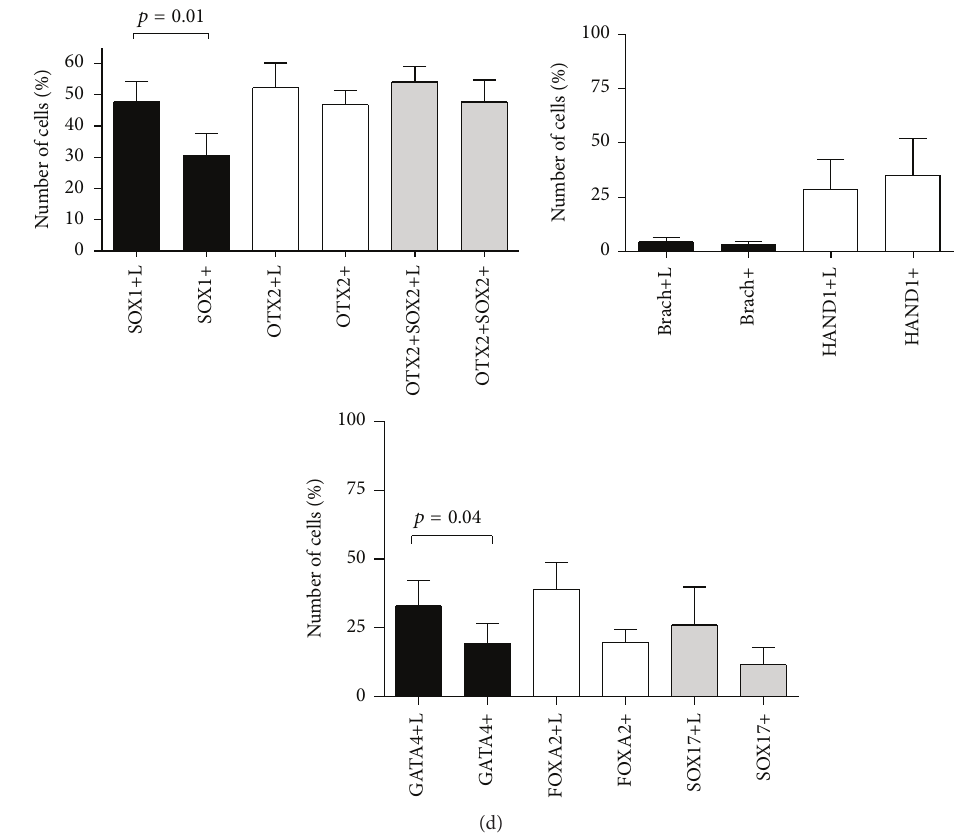
Figure 5: Expression of differentiation markers in hES cells during differentiation into ectodermal, mesodermal, or endodermal lineages after treatment with lovastatin. (a) Expression of the ectodermal lineage markers SOX1 and OTX2 in comparison to the expression of OCT4 and SOX2. (b) Expression of the endodermal lineage markers GATA4, FOXA2, and SOX17 in comparison to OCT4 expression. (c) Expression of the mesodermal lineage markers brachyury and HAND1 and in comparison to the expression of OCT4. (d) The mean number of cells ± SD ( 𝑛 = 5 ) expressing ectodermal (EC), mesodermal (ME), or endodermal (EN) lineage